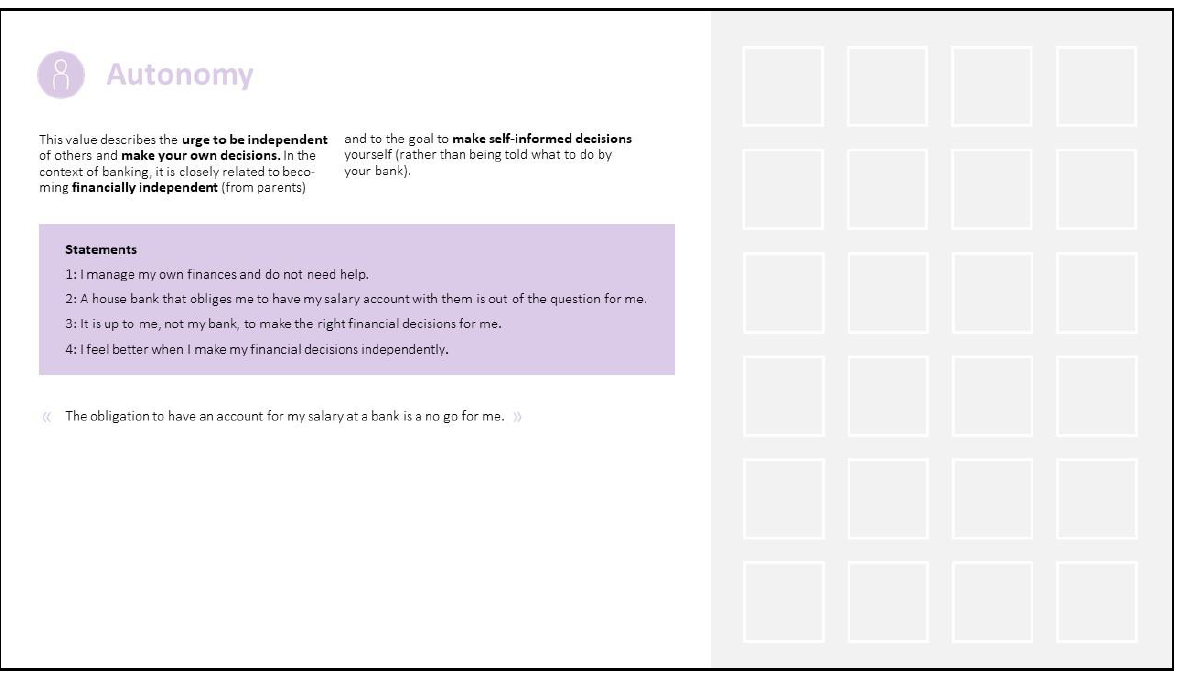
Figure 6. Needs Empathy Map (Phase II: Empathize).